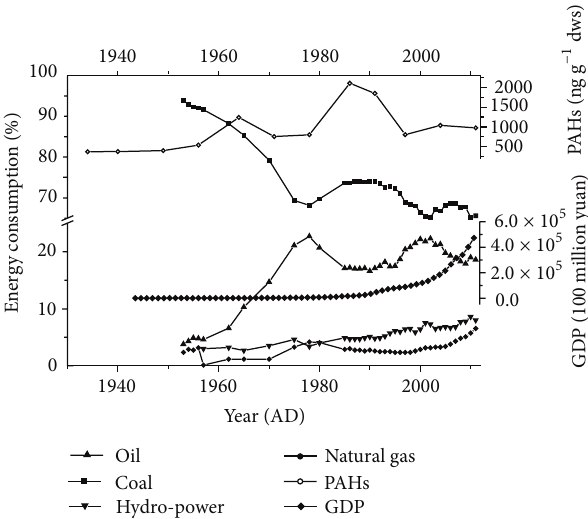
Figure 6: Relationship between sedimentary PAH concentrations (ngg −1 dws) in southern Bohai Sea and energy consumption of